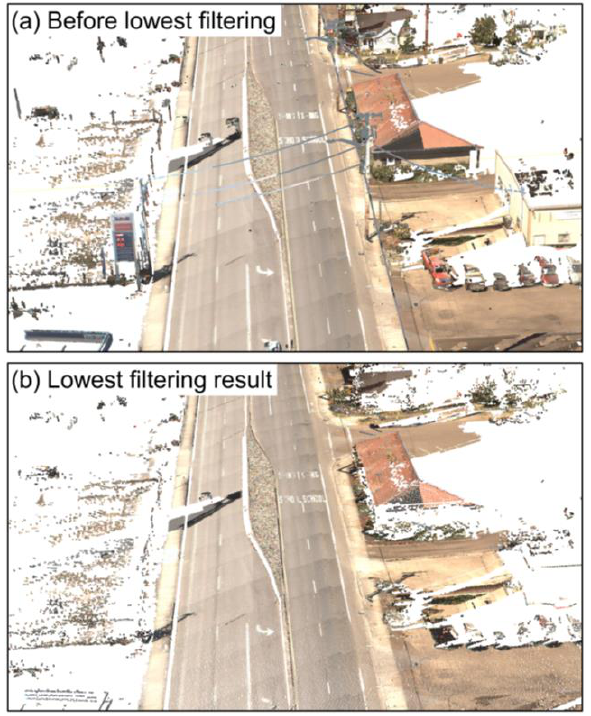
Figure 2 . Example of the proposed lowest point